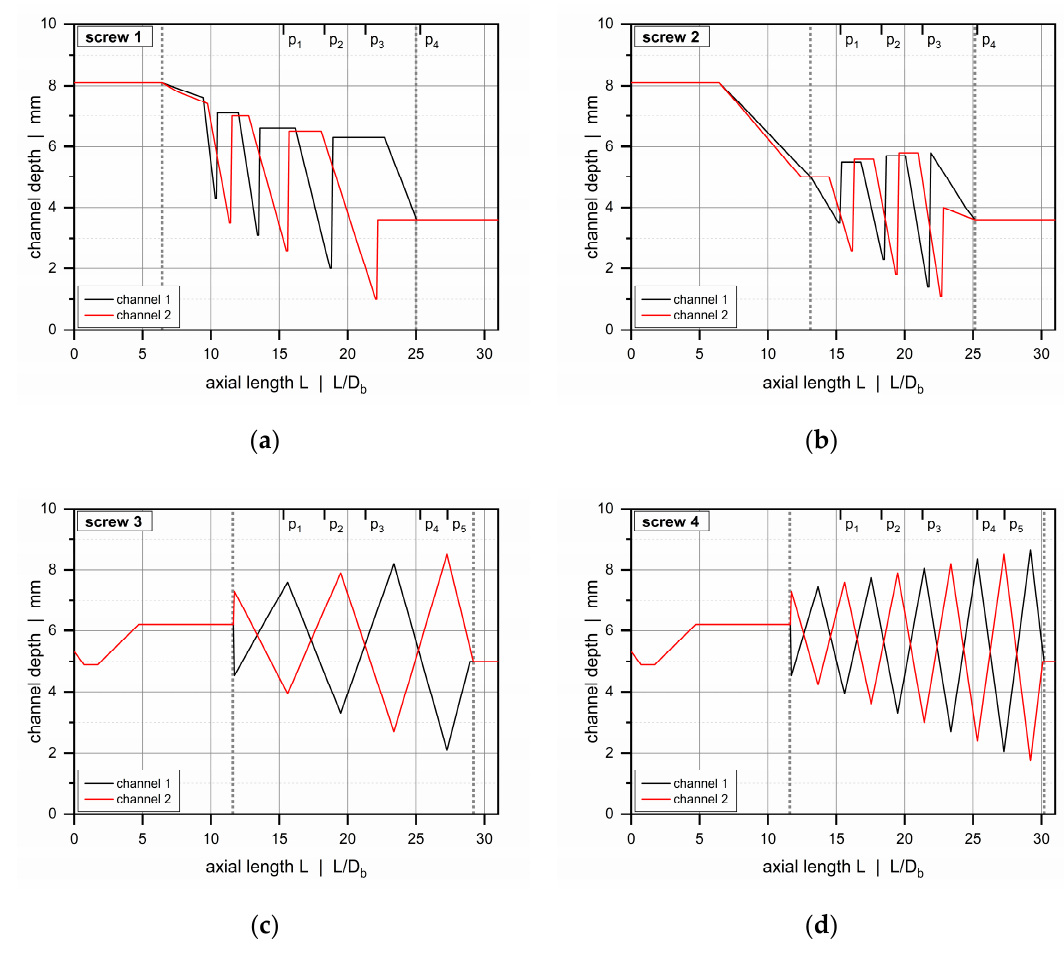
Figure 3. Comparison of channel-depth profiles: screw 1 ( a ), screw 2 ( b ), screw 3 ( c ), and screw 4 ( d ). The dotted vertical lines indicate the beginning and the end of the wave zone. The axial positions of the pressure transducers are shown at the upper x-axis.